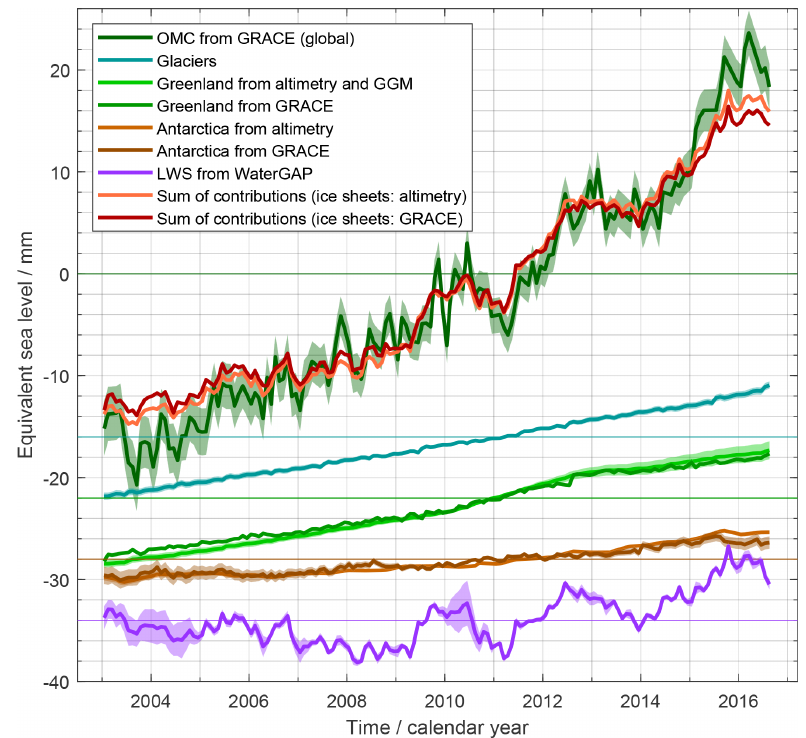
Figure 10. Time series of the elements of the ocean-mass budget in January 2003–August 2016. See legend for attribution of graphs. The GRACE-based time series and the Antarctic altimetry time series were interpolated to monthly sampling. Seasonal variations are subtracted. Each graph shows anomalies with respect to a mean value over 2006–2015. Graphs are shifted arbitrarily along the ordinate axis. Transparent bands show standard uncertainties (except for the red sum-of-contribution